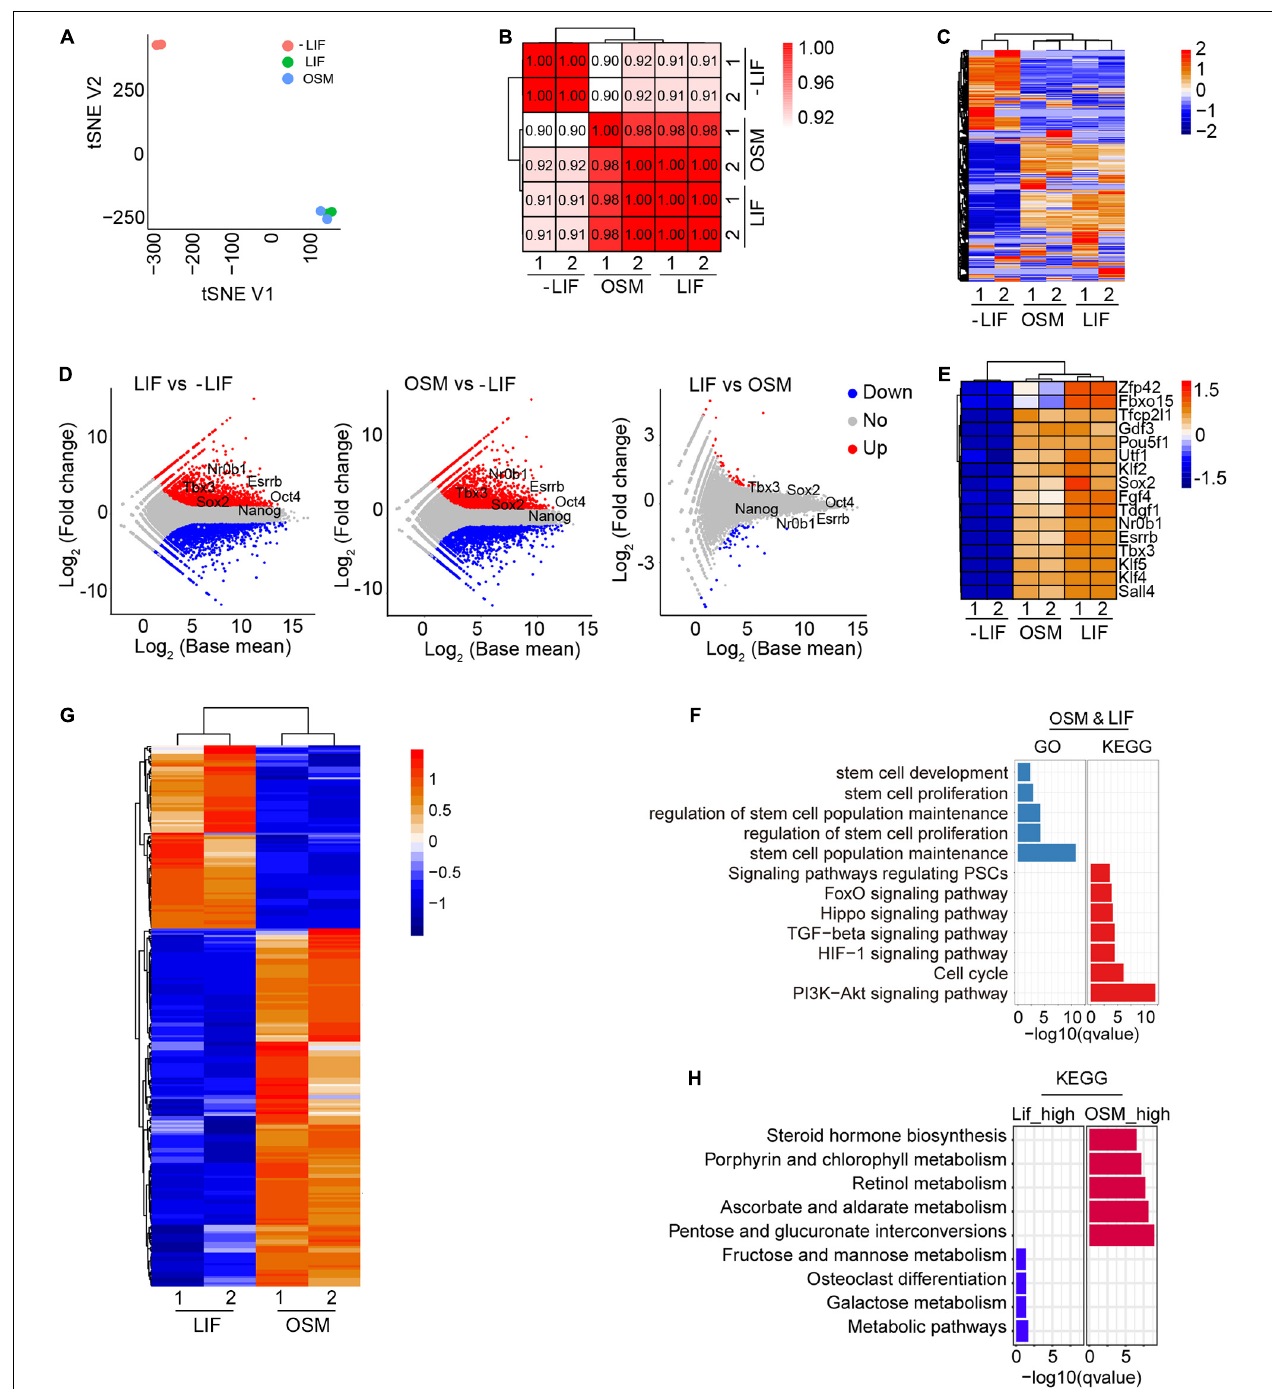
FIGURE 4 | Transcriptome and signal pathways in ESCs cultured in OSM medium. (A) tSNE analysis of ESCs cultured in -LIF, LIF, and OSM medium by RNA-seq. (B) Pearson’s correlation coefficient graph of mESCs cultured in -LIF, LIF, and OSM medium. The value of 1.0 represents perfect positive correlation and 0 represents no correlation between the two samples. (C) Heatmap displaying global gene expression profile of mESCs cultured in -LIF, LIF, and OSM medium. Color key from red to blue represents the relative gene expression level from high to low. (D) Scatter-plots showing the differential expression genes in mESCs cultured in -LIF, LIF, and OSM medium. Parallel diagonal lines indicate twofold threshold in expression difference ( P < 0.05). (E) Heatmap of expression profile of pluripotent genes in ESCs cultured in -LIF, LIF, and OSM medium. (F) GO and KEGG analysis of genes expressed without differences (fold change < 1.5) in LIF-ESCs and OSM-ESCs. (G) Heatmap illustrating differentially expressed genes (DEGs) between mESCs cultured with LIF and with OSM. Two biological replicates were analyzed per group. Genes with ≥ 0.5-fold expression changes, P -value < 0.05 were chosen for heatmap. (H) KEGG analysis of upregulated genes in mESCs cultured in OSM medium and those in LIF medium,